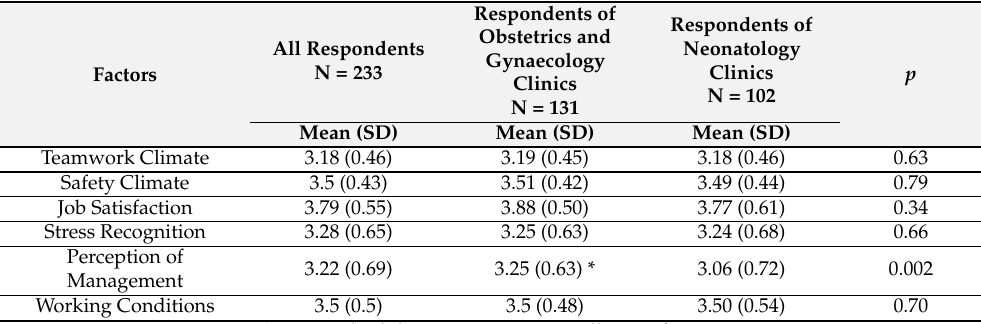
Table 3. SAQ factor, mean scores, and standard deviations of the obstetrics and gynaecology clinics and neonatology clinics.